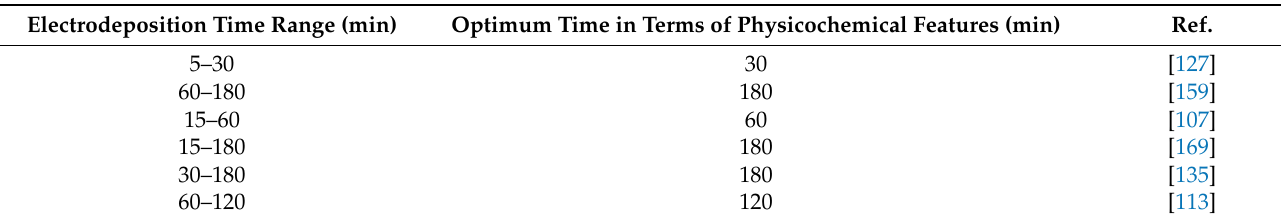
Table 5. The reported electrodeposition time range and the optimum time for obtaining favorable physicochemical features in the HAp coatings.